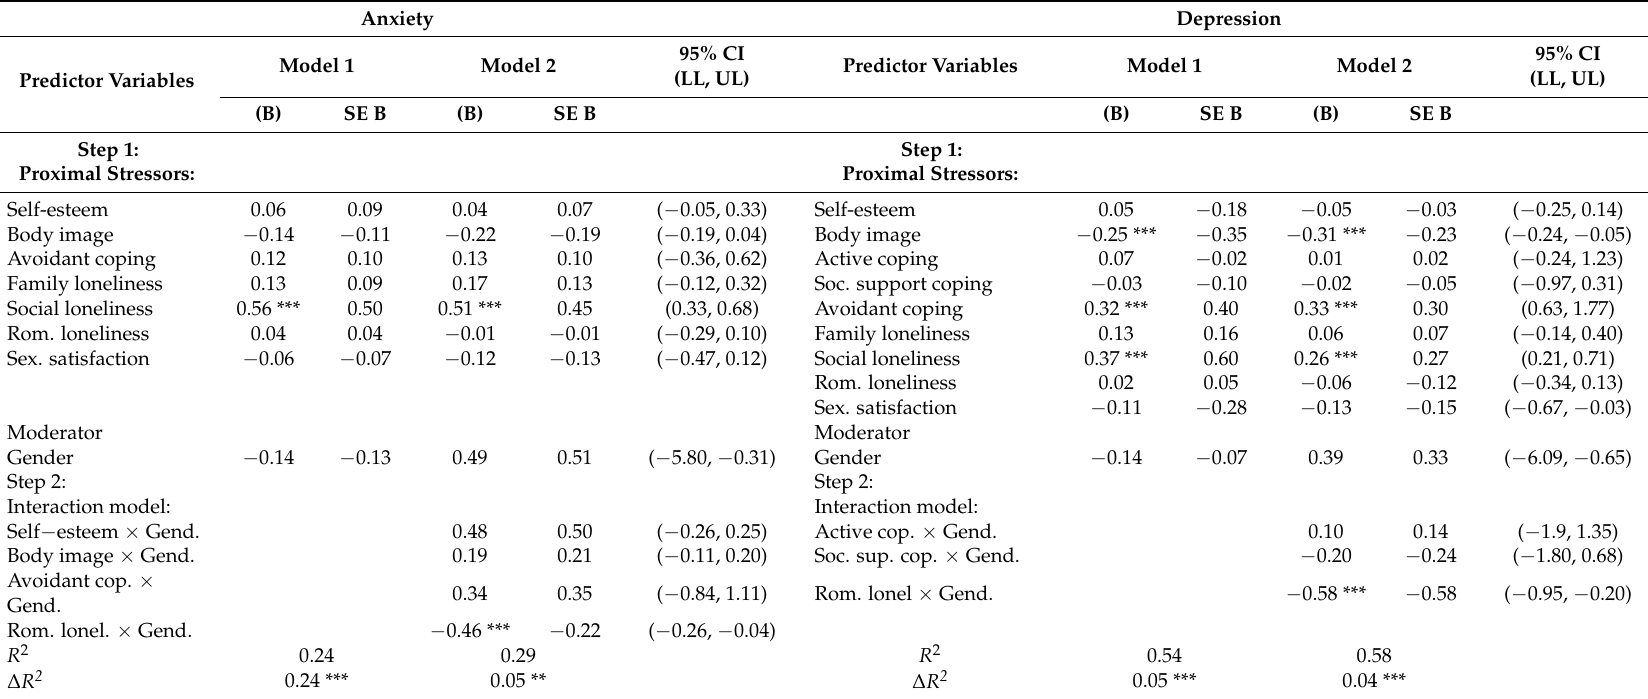
Table 4. Hierarchical multiple regression analysis with anxiety and depression as dependent